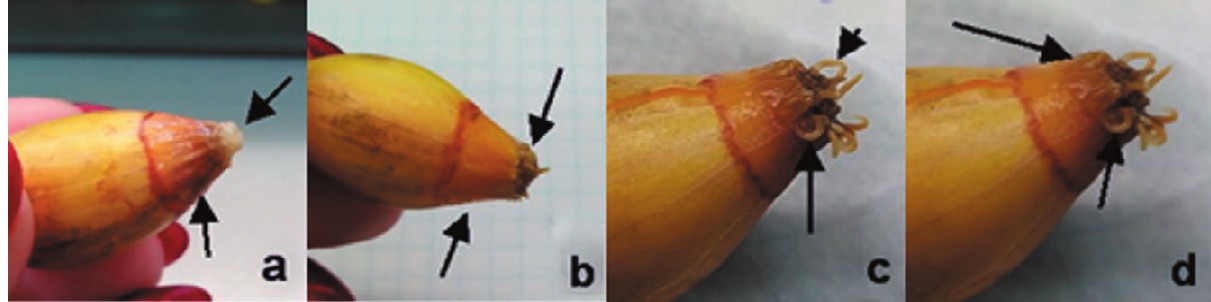
Figure 2. Death of roots in 100% aqueous extracts of inflorescences after 96 h (a, b) and bending of roots after exposure to aqueous extract of inflorescences and leaves 20, 50 and 80% after 48 h (c, d).